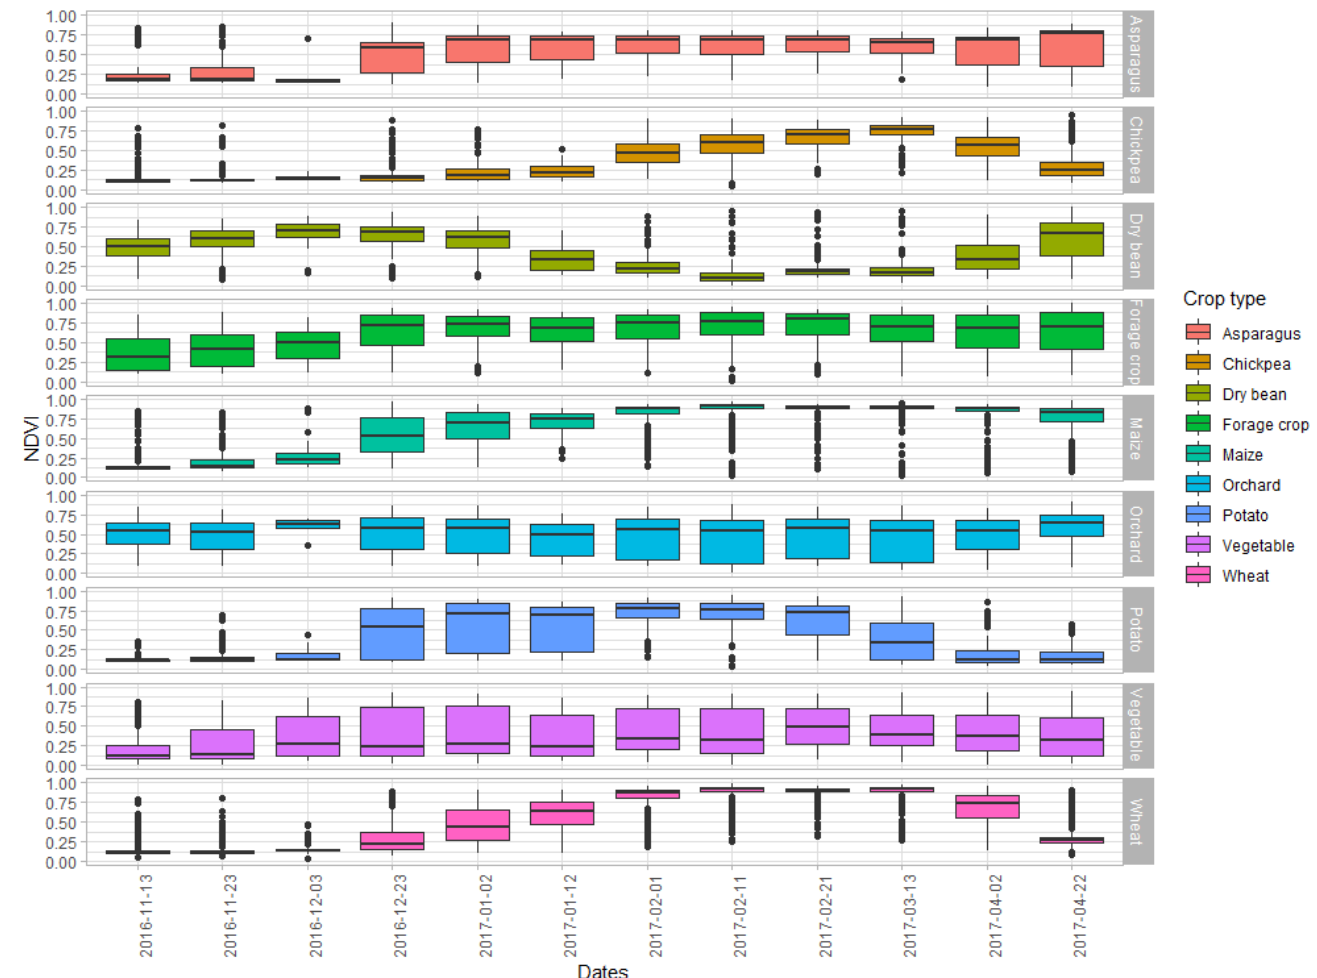
Figure 3. Development of NDVI of the major crop types across the growing season. The dates indicate the acquisition dates of the cloud-free Sentinel-2A images during the study period.